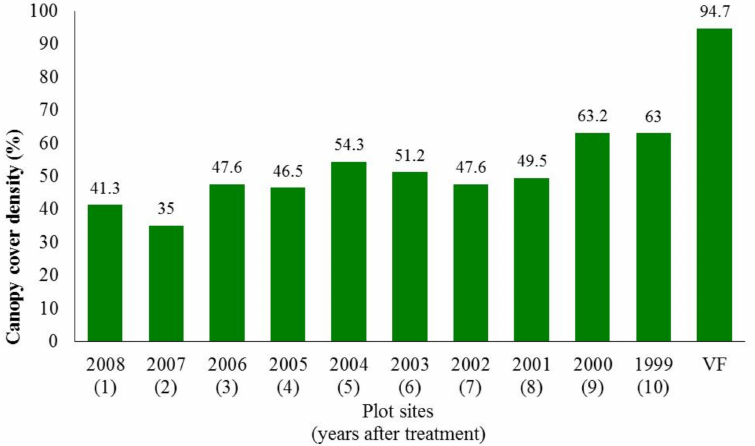
Figure 9. Average canopy cover density measured in permanent sample plots at different IFMS sites and the virgin forest